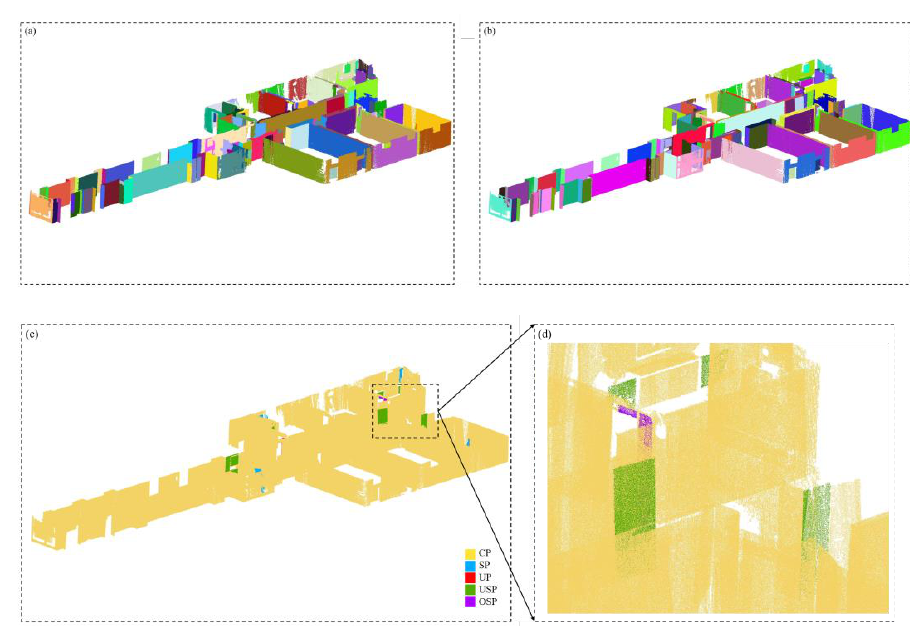
Figure 13. Plane-segmentation result for the TUB1 dataset: ( a ) proposed method, ( b ) ground truth, ( c ) the main differences between ( a ) and ( b ), and ( d ) enlarged part.